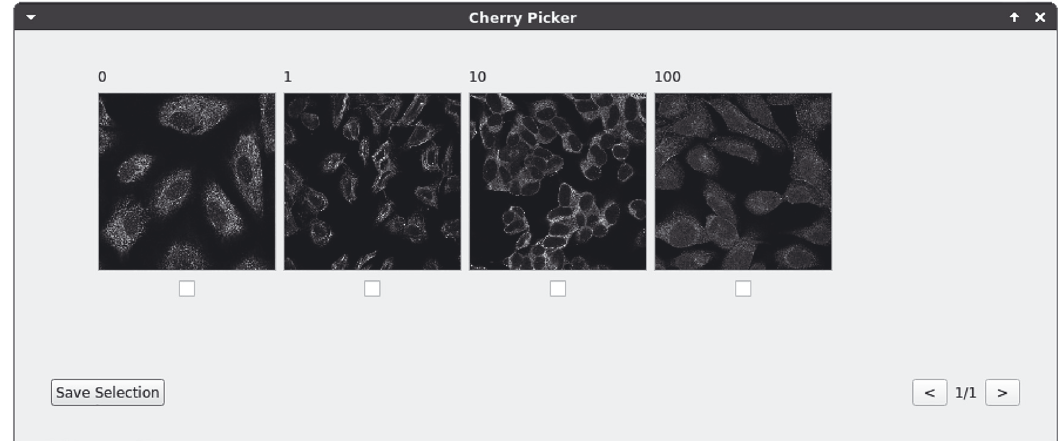
Figure 5: GUI cherry picker. KaIDA shows a GUI for cherry-picking images of the human brain atlas [30] via user input. The selected images would appear first during the annotation